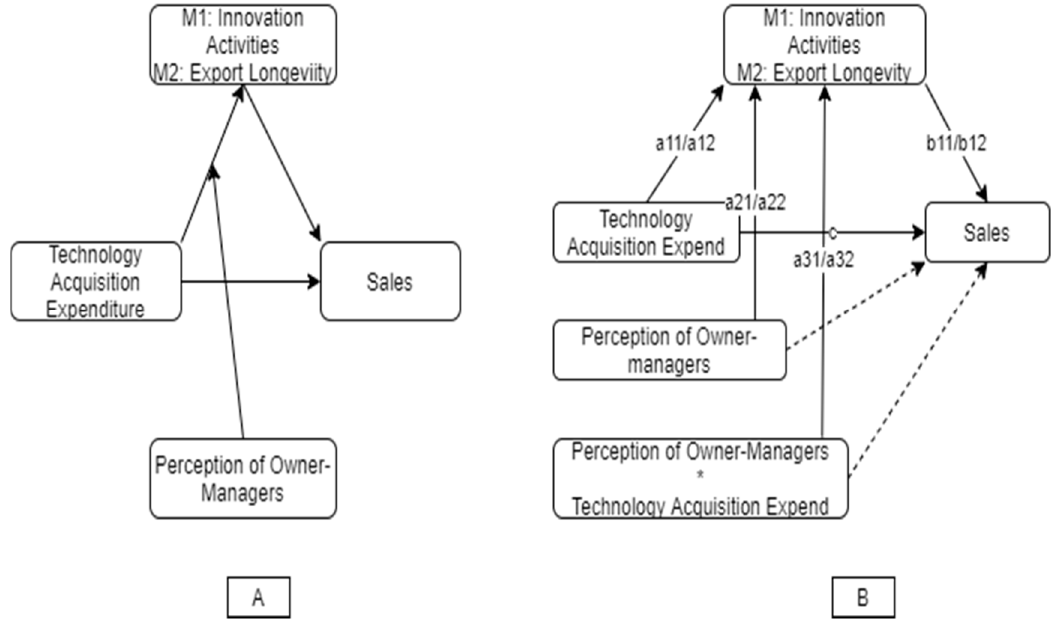
Figure 1. Conceptual ( A ) and statistical ( B ) frameworks .